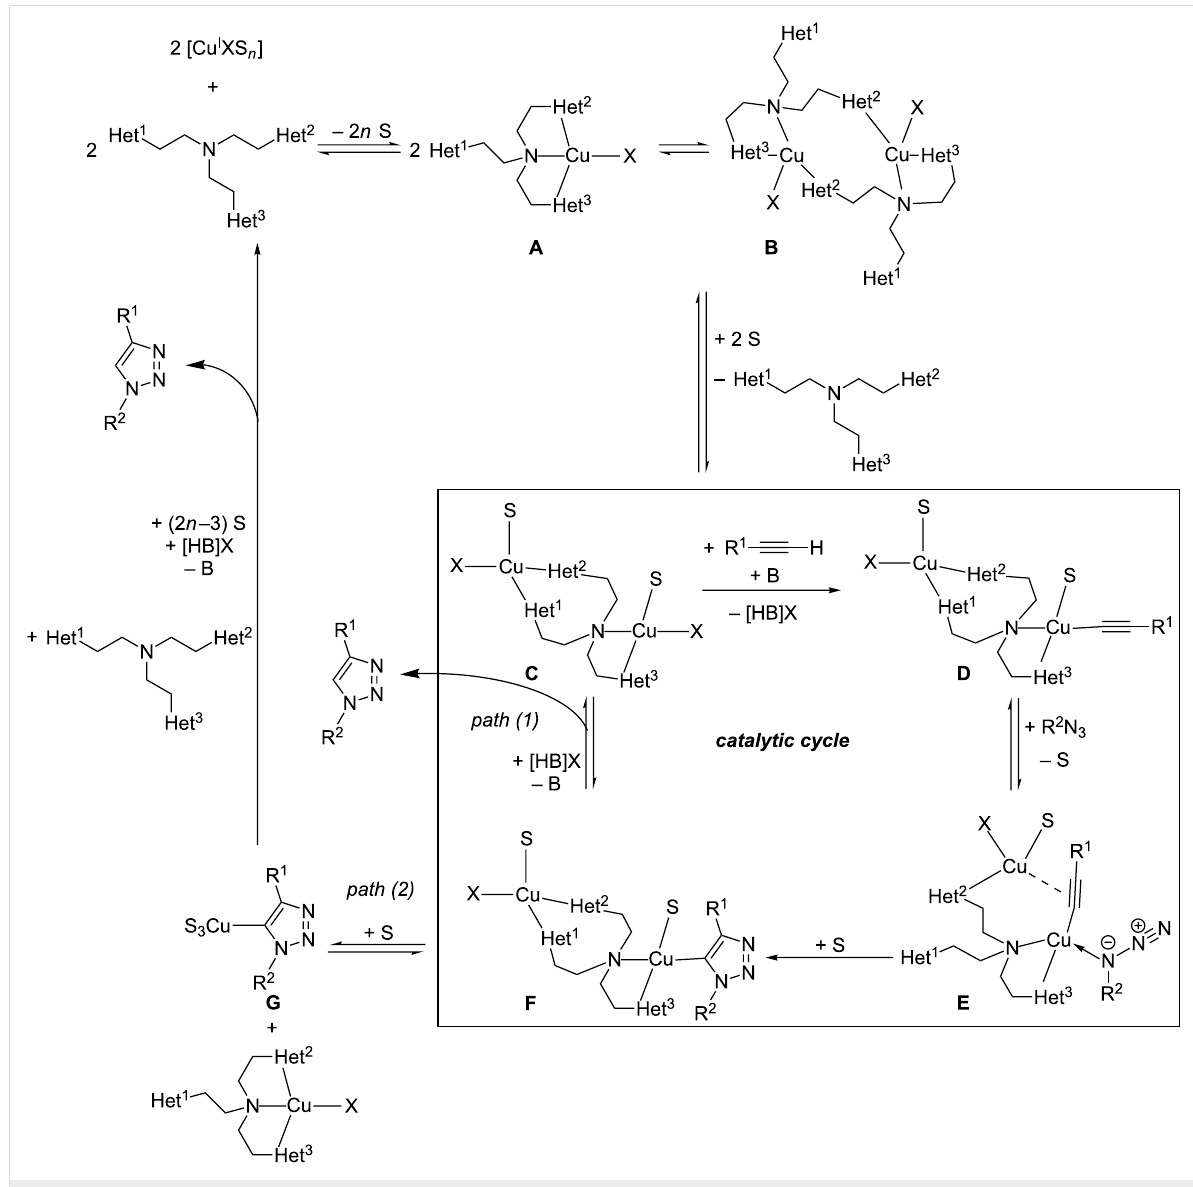
Scheme 20: Mechanistic scheme for ligand-accelerated catalysis with tripodal tris(heteroarylmethyl)amine ligands in consideration of solvent coordi- nation and formation of inhibitory species (S = solvent molecule; B = base; X = halide; n = integer number; Het 1 , Het 2 , Het 3 = coordinating heteroaryl substituent such as benzimidazolyl, triazolyl, pyridyl or benzothiazolyl in the tripodal ligand; for examples please consult Figure 1, Table 1 and Figure 6)